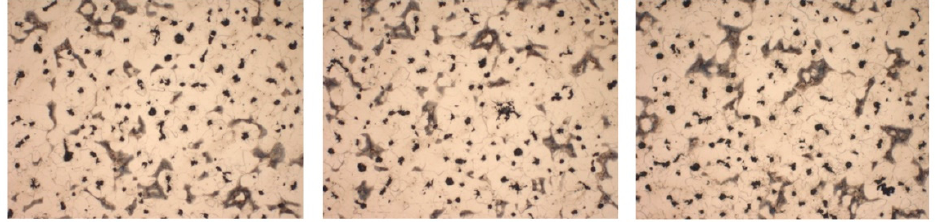
Figure 22. Microstructure of cast iron samples with spheroidal graphite type EN-GJS-400-15, after metallographic attack at 100× magnification.